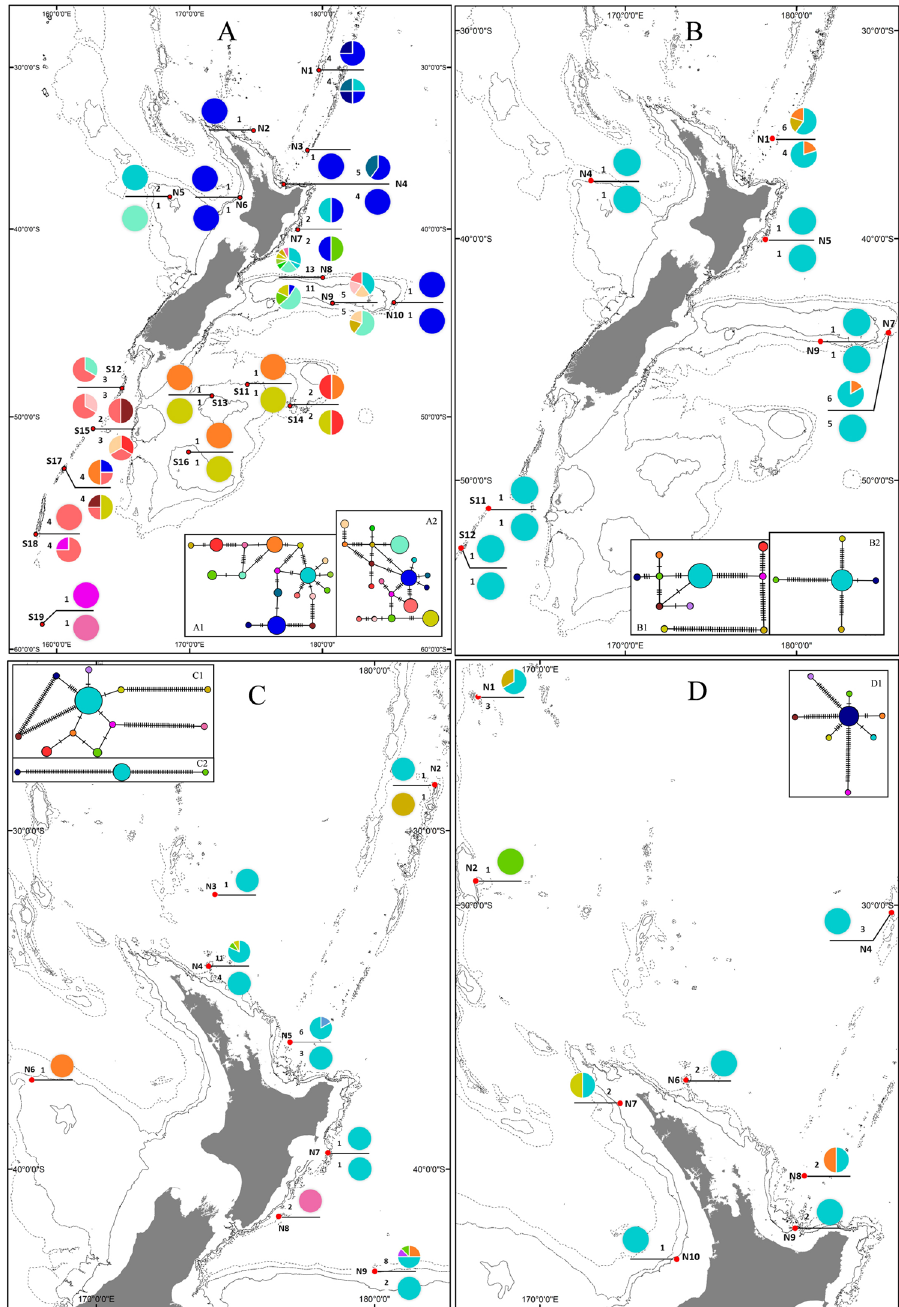
Figure 1. Haplotype maps for Poecillastra laminaris - COI (above line) and Cytb (below line). ( A ) Penares sp. COI (above line) and 12S (below line). ( B ) Neoaulaxinia persicum COI (above line) and 12S (below line). ( C ) Pleroma menoui COI . ( D ) Insets A1, B1, C1 and D1 are the COI haplotype networks for Poecillastra laminaris , Penares sp., Neoaulaxinia persicum and Pleroma menoui , respectively. Inset A2 is the Cytb haplotype network for Poecillastra laminaris , and insets B2 and C2 are the 12S haplotype networks for Penares sp. and Neoaulaxinia persicum ,